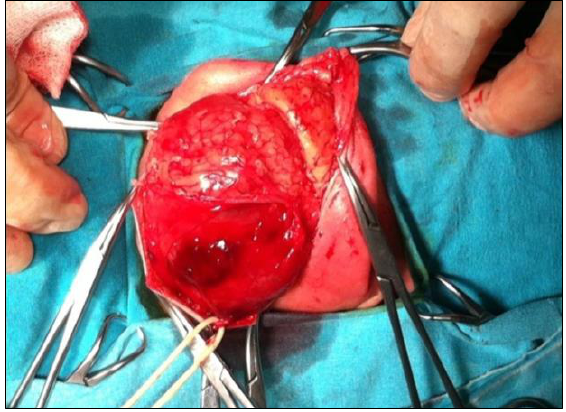
Figure 3: The cystic mass was excised totally with presser- ving of vessels and nerves of the neck by submandibular transverse